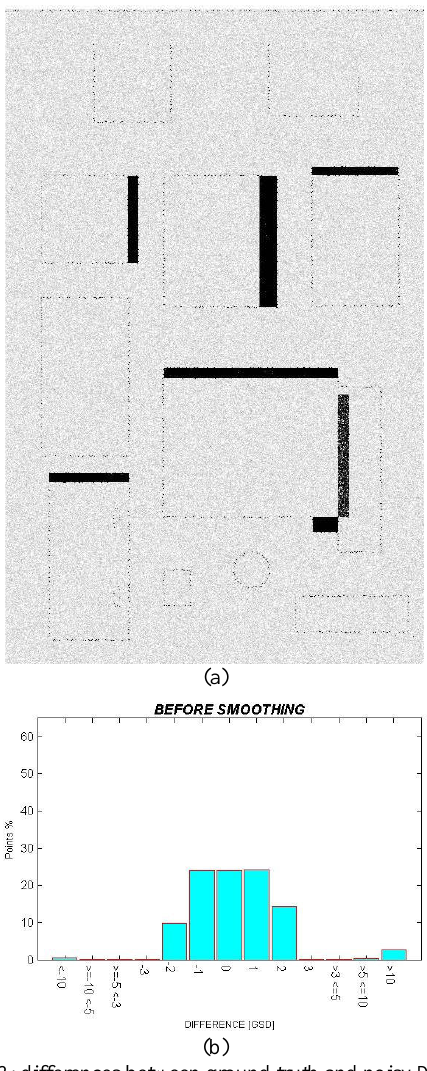
Figure 3: differences between ground truth and noisy DSM (a) and histogram of the differences expressed in GSD